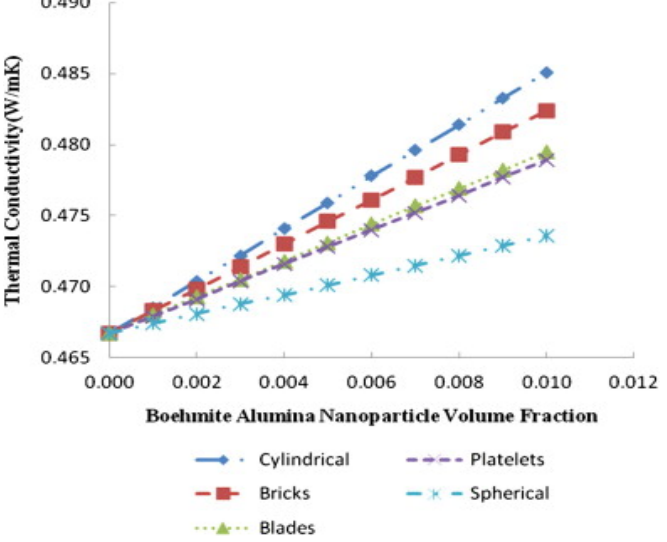
Figure 8. Effects of different particle shapes on the thermal conductivity of a nanofluid [59].